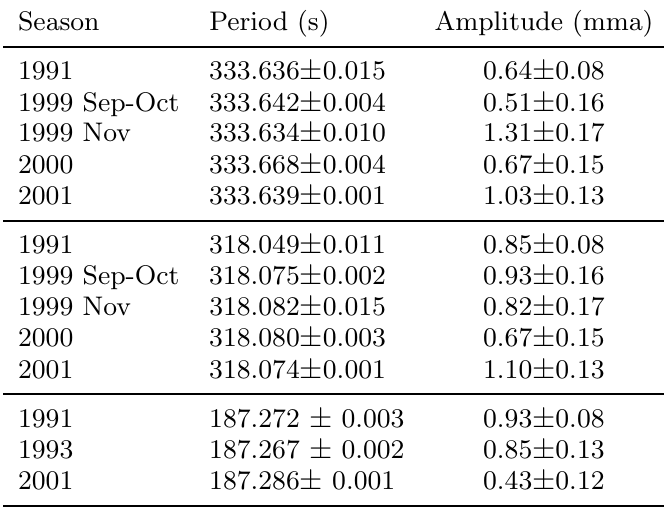
Table 5. Period and amplitude measurements for the additional pulsation